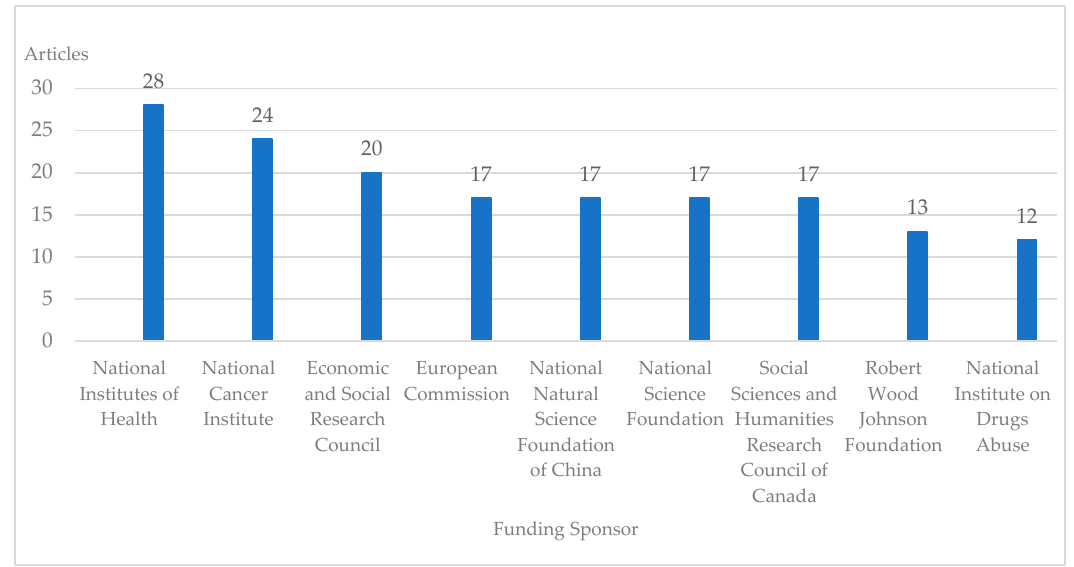
Figure 8. Articles by funding sponsor.